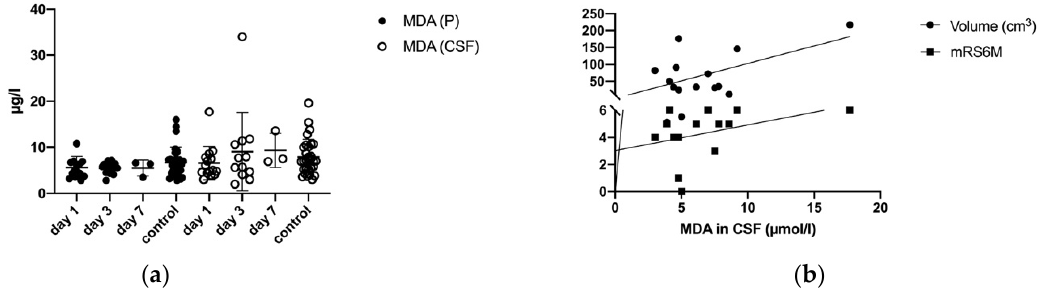
Figure 5. ( a ) Development of MDA levels in plasma (P) and CSF in ICH patients and control group (day 1, day 3, and day 7) ( b ) Correlation of mean MDA levels in CSF with mRS after 6 months ( p = 0.05) and MDA (CSF) at day 1 with the volume of ICH ( p = 0.01).